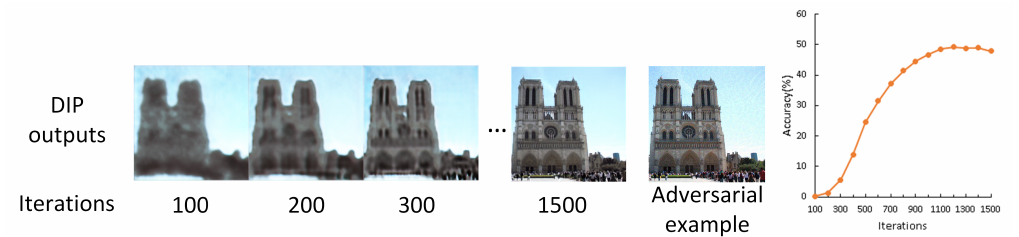
Figure 3. The ability of deep image prior to recover original image from adversarial example. The accuracy of Inception v-3 with no defense is